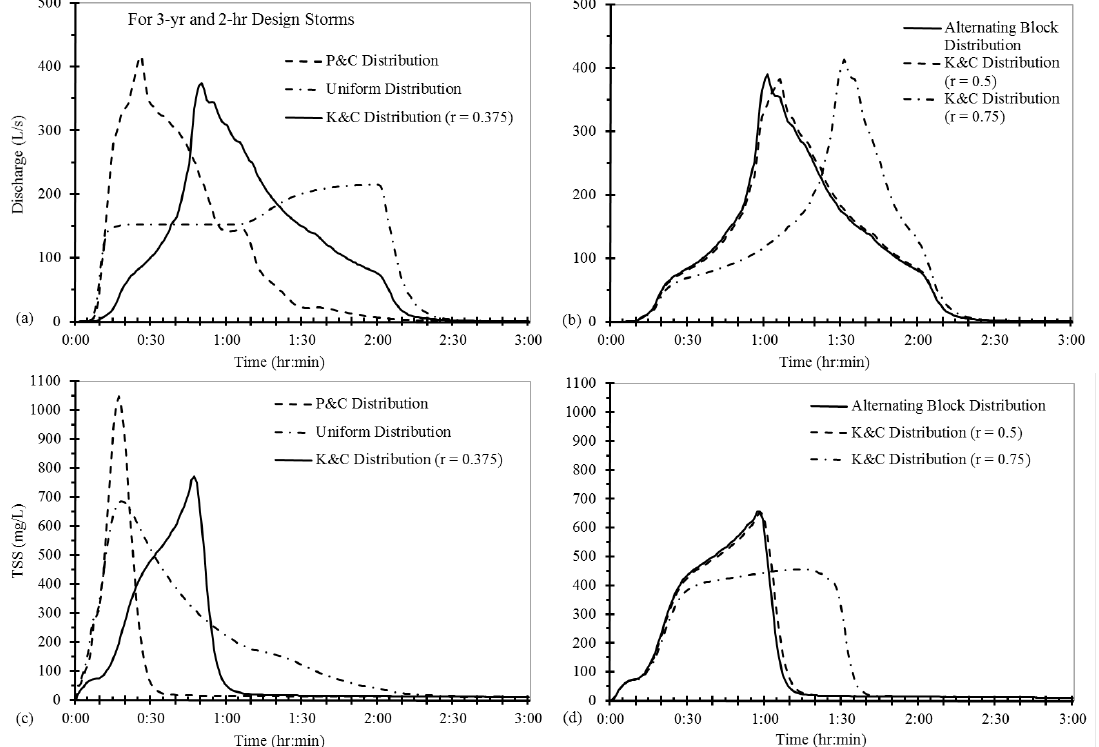
Figure 8. Simulated discharge (L/s) ( a , b ) and TSS concentration (mg/L) ( c , d ) at the catchment outlet for different three-year, 2-h design rainfall distributions.